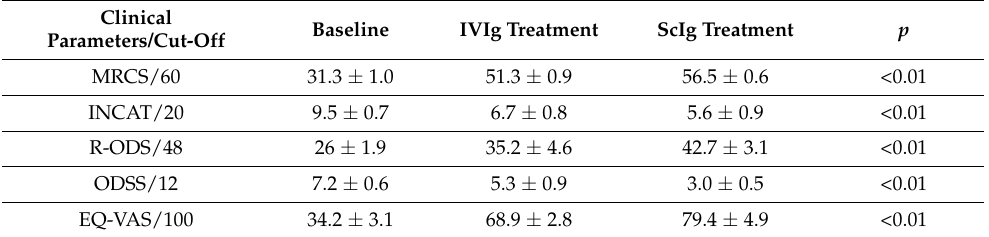
Table legend. ScIg: subcutaneous immunoglobulin; MRCS: Medical Research Council sum score; INCAT: inflam- matory neuropathy cause and treatment; R-ODS: Rasch-built overall disability scale; ODSS: overall disability sum scale; EQ-VAS: EuroQol visual analogue scale. Baseline vs. ScIg treatment.